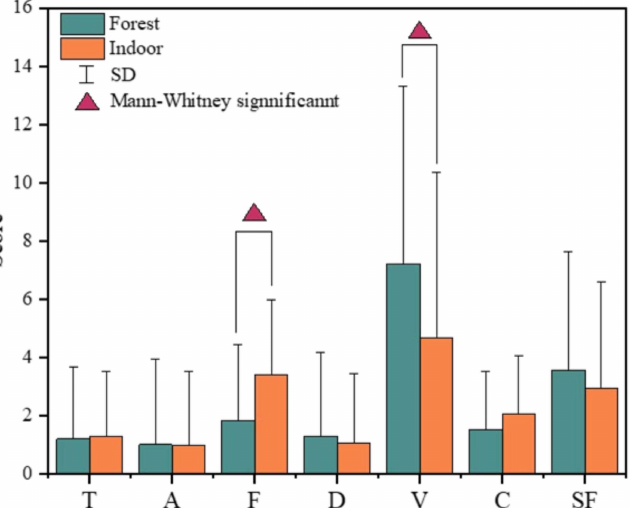
Figure 8. The Profile of Mood States (POMS) scores after natural and indoor